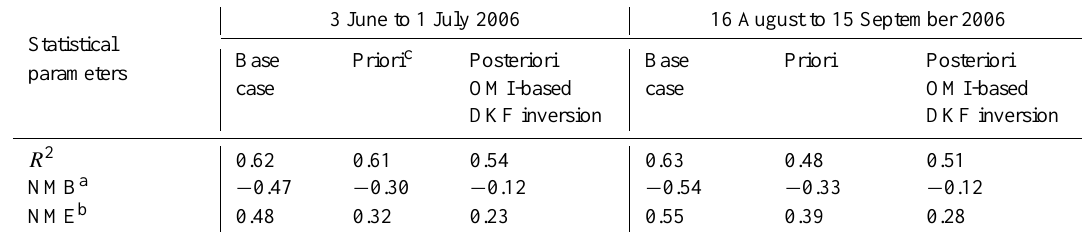
Table 3. Performance of CAMx in simulating OMI-observed NO 2 column densities.